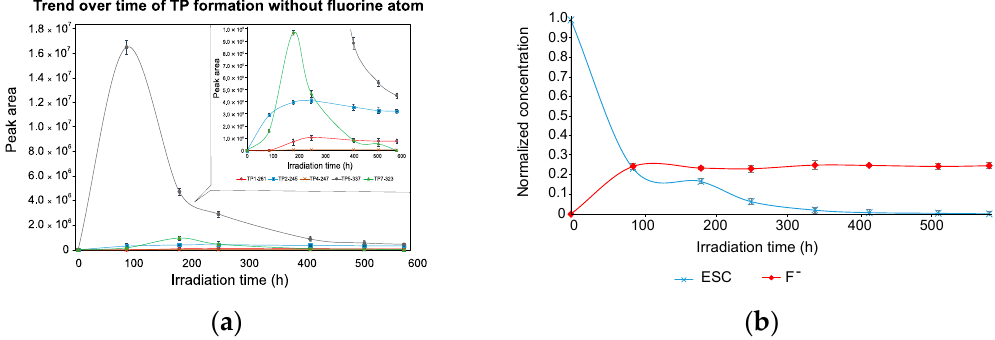
Figure 5. Time evolution of ( a ) peak areas of TPs that have lost the fluorine atom (TP1 at m/z 261, TP2 at m/z 245, TP4 at m/z 247, TP5 at m/z 337 and TP7 at m/z 323) with a zoom-section on the smallest TP peak areas, and ( b ) the related fluoride formation.